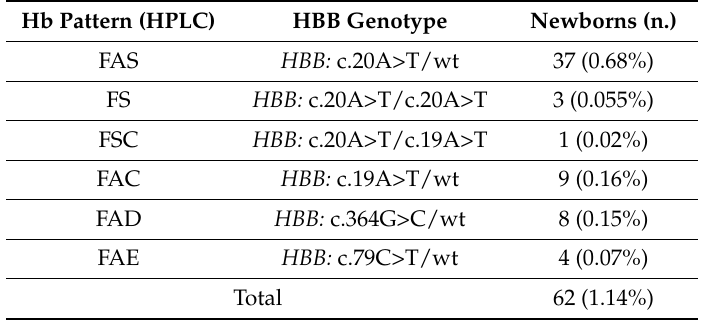
Table 1. Hemoglobin patterns observed in the pilot newborn